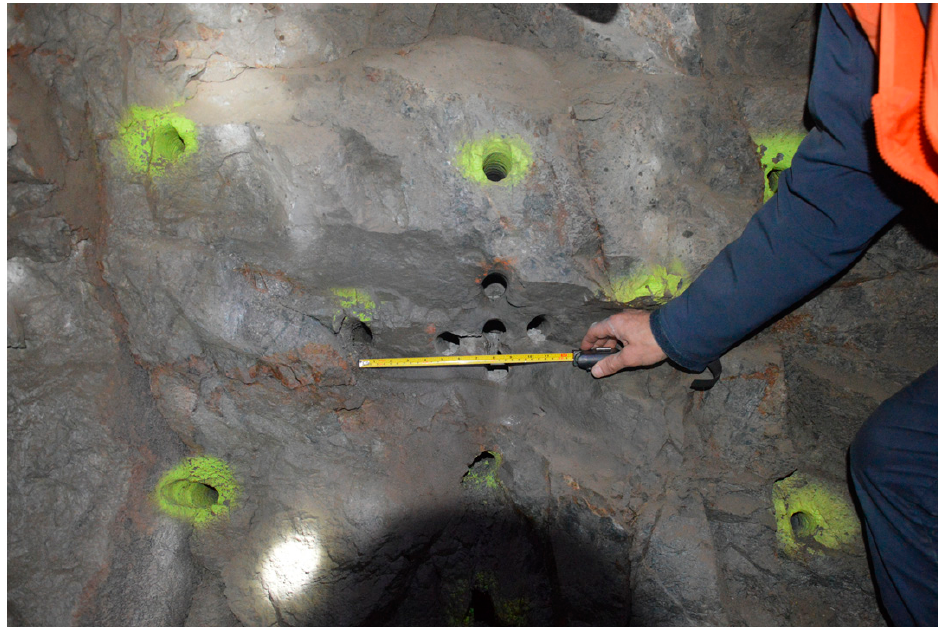
Figure A1. Burn cut after detonation of central hole with sequence number zero.